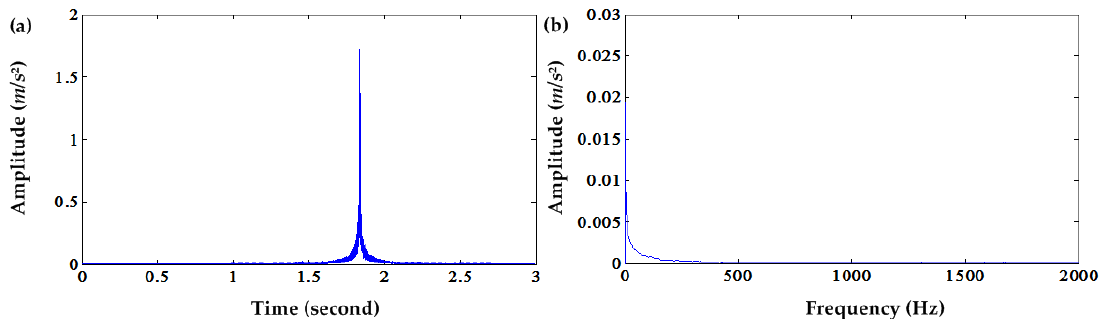
Figure 4. ( a ) Squared envelope signal after the 100th DC offset cancellation; ( b ) squared envelope spectrum after the 100th DC offset cancellation.